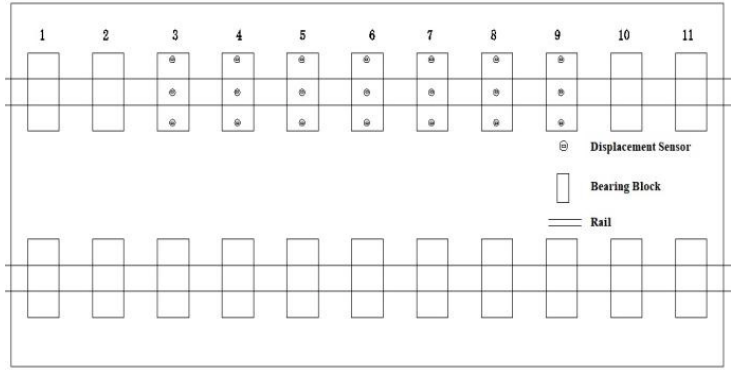
Figure 12. Layout of measuring points for working condition 1.